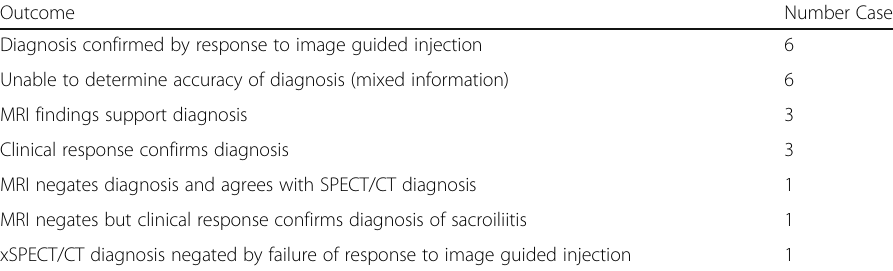
Table 1 Follow-up data in 21 cases where the xSPECT-CT changed the final report diagnosis Outcome Number